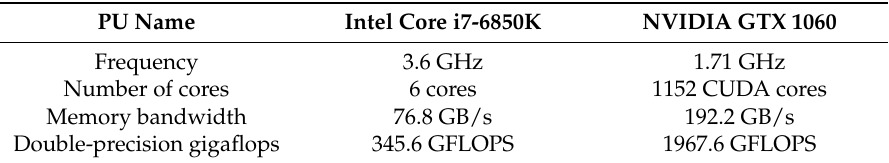
Table 2. Detailed information of experimental PUs on hpc_02.